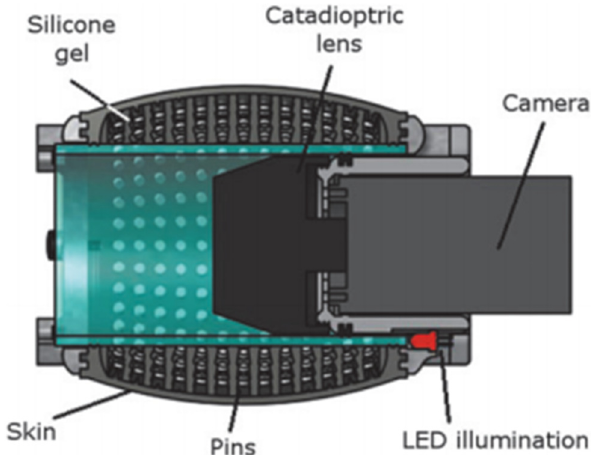
Figure 23. TacTip endoscopic visual contact sensor [28] (Open Access).